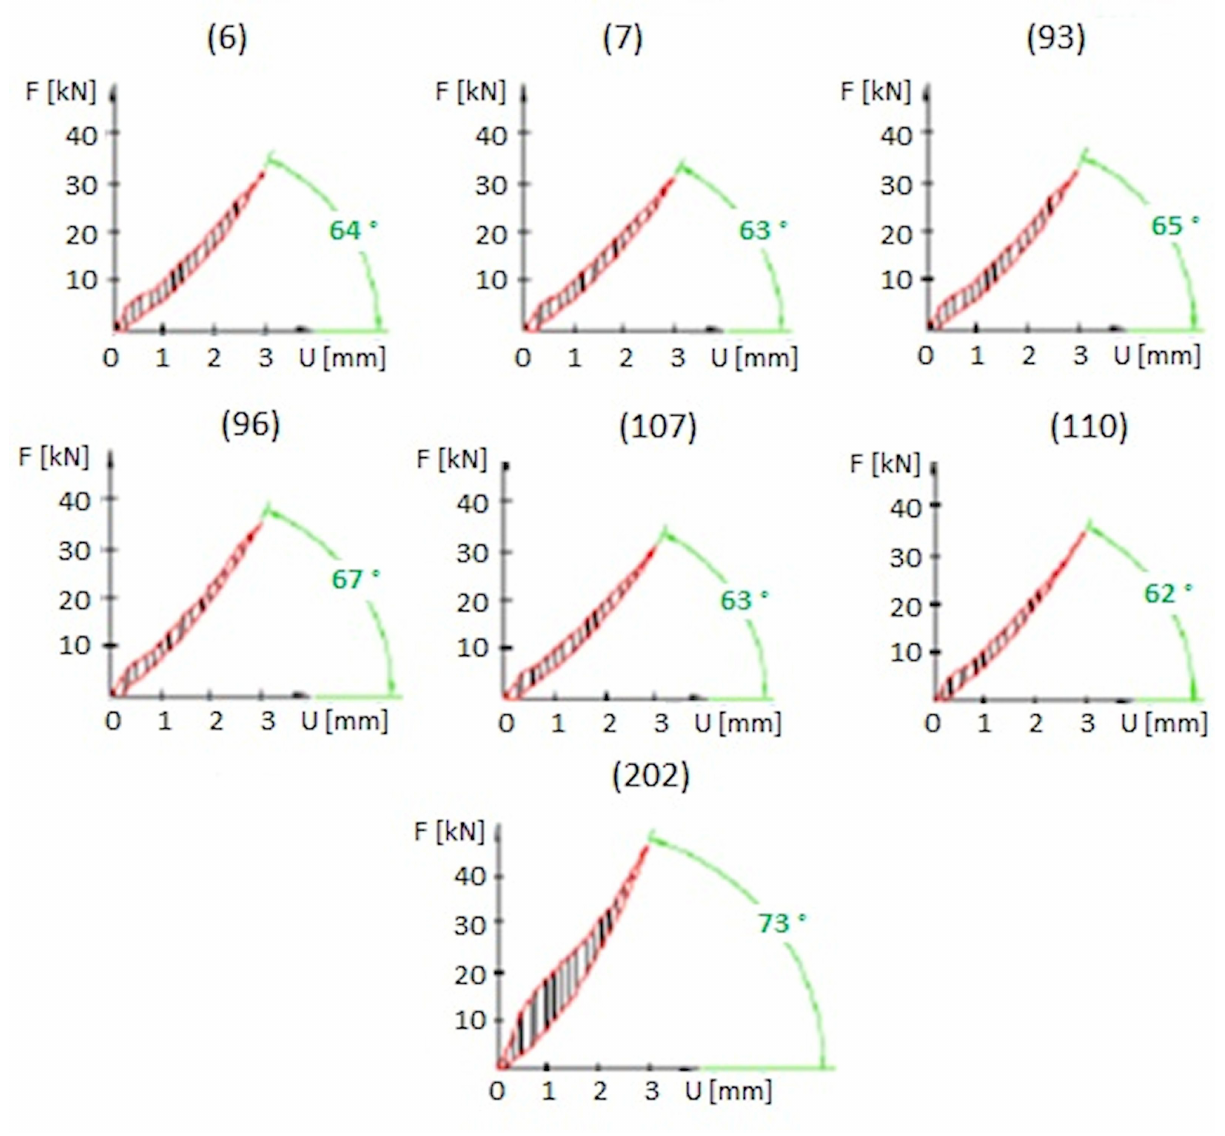
Figure 11: The stiffness characteristics of the selected gasket’s variants that met all the